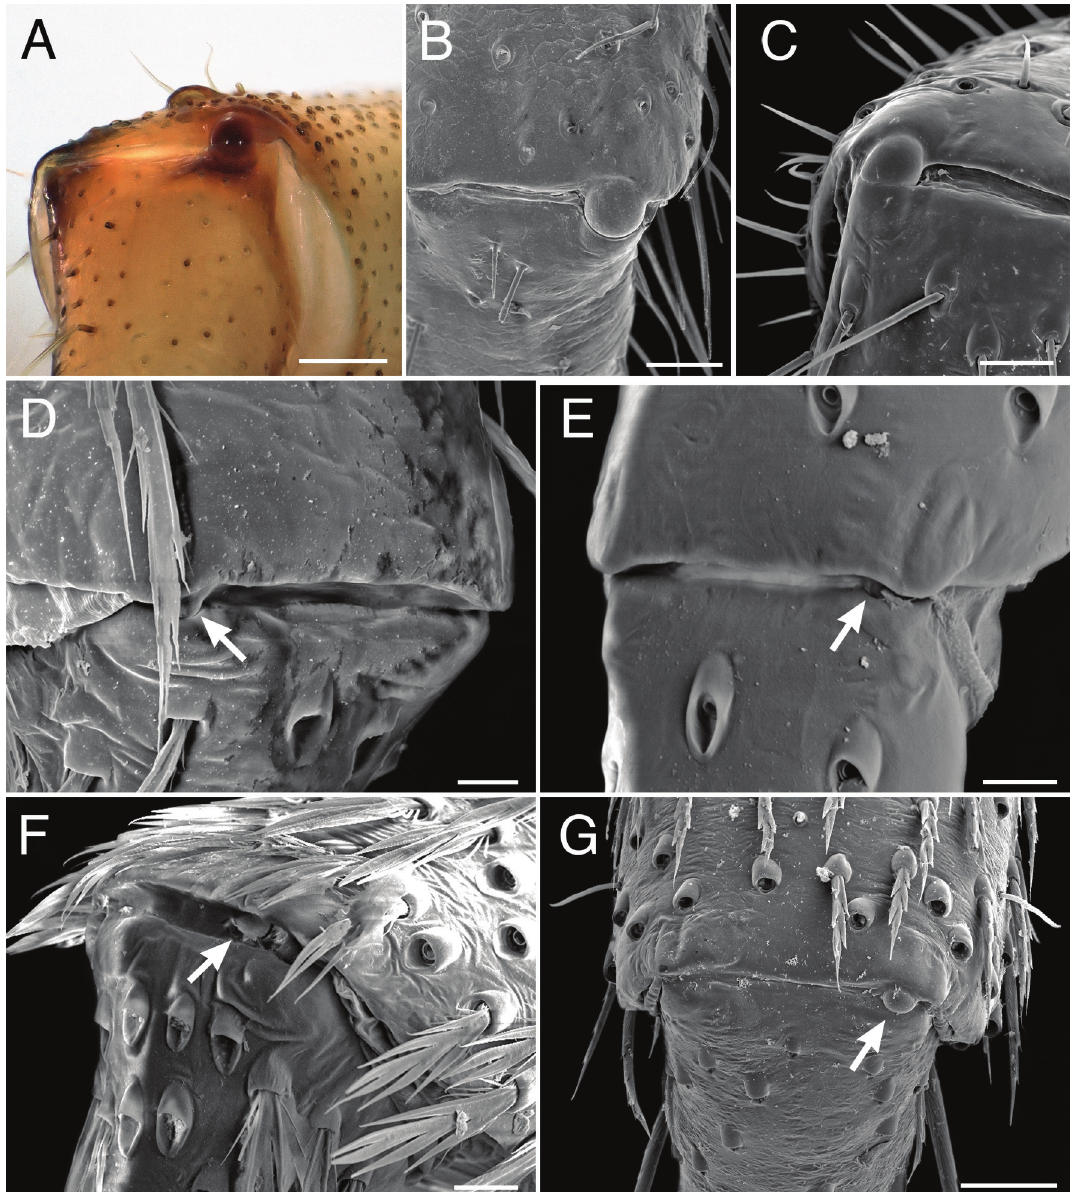
Fig. 19. A . Lachesana blackwalli (O. Pickard-Cambridge, 1872), ♂, right tibia and metatarsus III, dorsal view. B . Mallinella sp., ♂, right tibia and metatarsus II. C . Suffrica gus Henrard & Jocqué, 2015, ♂, left tibia and metatarsus I. D . Zodarion nesiotes Denis, 1965, ♀, right tibia and metatarsus I. E . Microdiores sp., ♂, right tibia and metatarsus I. F . Ranops caprivi Jocqué, 1991, ♂, right tibia and metatarsus II. G . Diores milloti Jocqué, 1990, ♀, right tibia and metatarsus I. Scale bars: A = 100 mm, B, G = 50 mm, c, F = 20 mm, d–e = 10 mm. Arrow shows tibial process, asterisks indicate